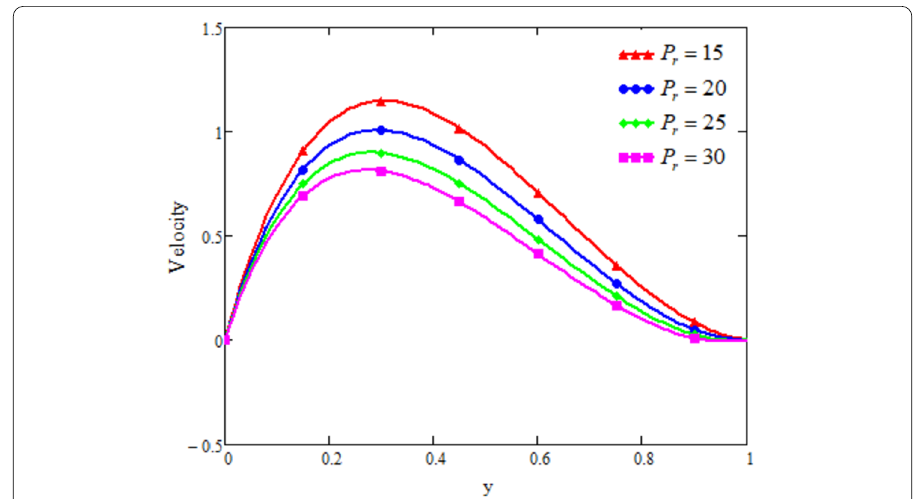
Figure 6 Velocity curves along P r variation and α = 0.5, G r = 15.5, K = 12.5, λ = 1.9, λ 1 = 1.6, H a = 0.8, t = 5